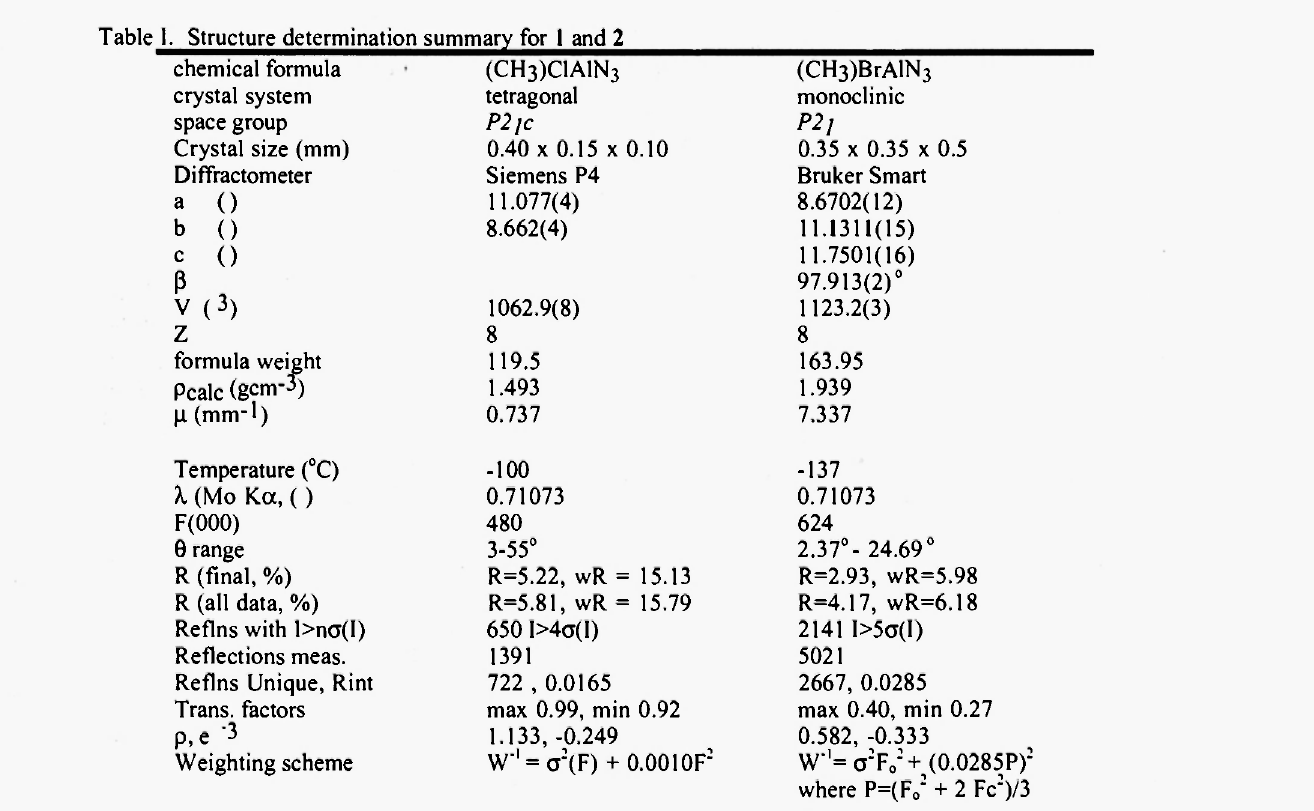
Table 1. Structure determination summary for 1 and